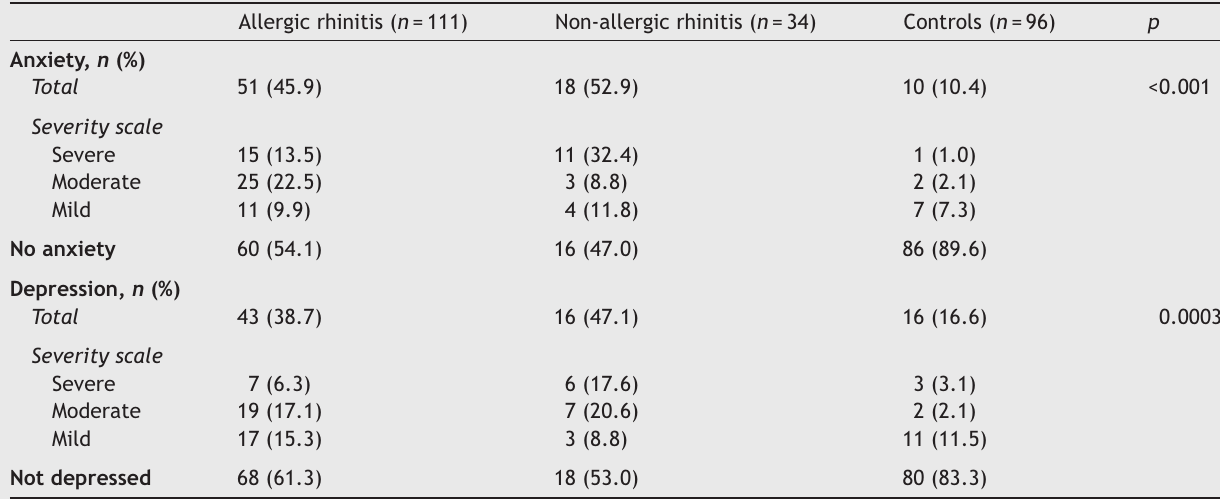
Frequency of anxiety and depression symptoms based on the type of